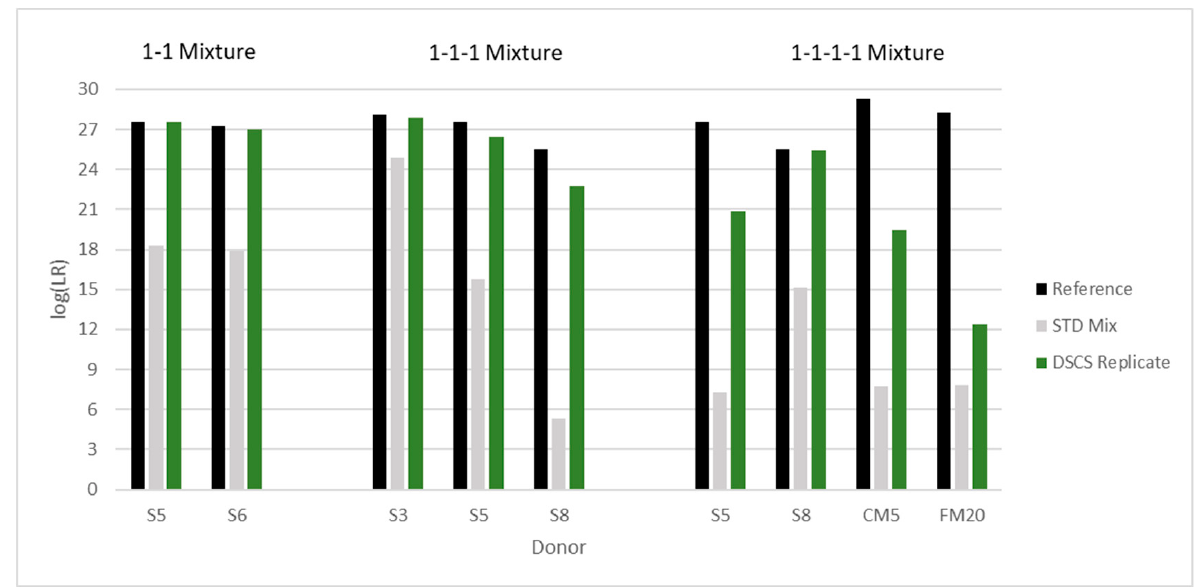
Figure 16. Increased contributor log(LR) recovery in 2–4 person mixtures by DSCS (EFM) (“DSCS Replicate”) compared to standard PG mixture analysis (STD Mix). The “Reference” LR is the reciprocal of the random match probability of the single source DNA profile from the known donor. The alphanumeric characters refer to the individual donors present in the mixture.